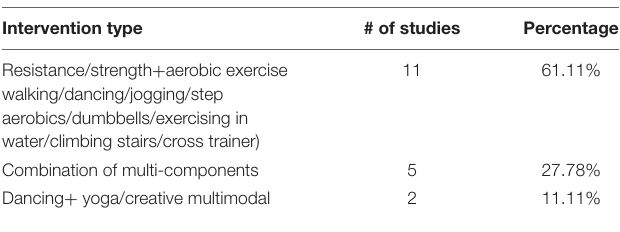
TABLE 4 | Ranking of interventions based on numbers of